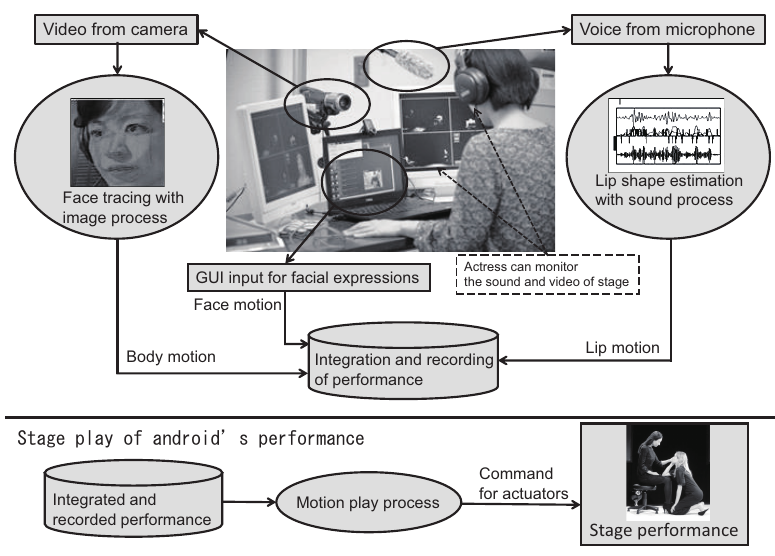
Figure 2. System of android